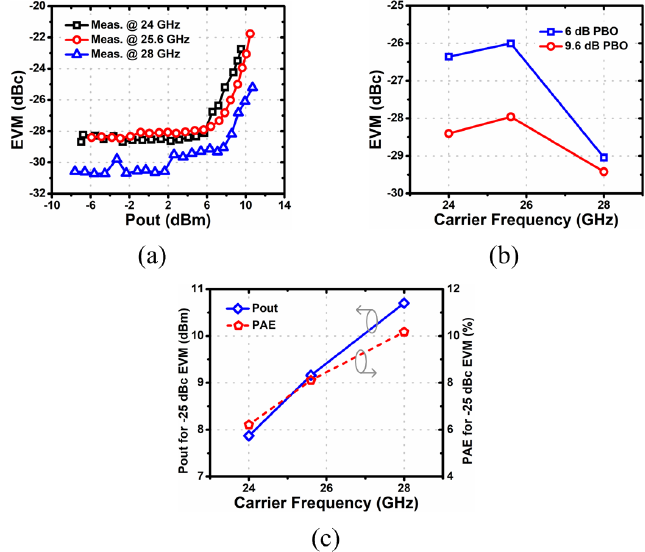
Figure 9. ( a ) EVM versus average 64-QAM output power for 250 MHz BW sig at 24 / 25.6 / 28 GHz, ( b ) EVM versus carrier frequency at 6 / 9.6 dB PBO, ( c ) average output power and corresponding PAE versus carrier frequency at fixed EVM of − 25 dBc. Table 1. Performance summary and